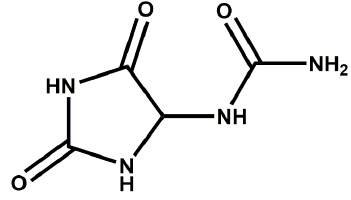
Scheme 1. The structure of allantoin.